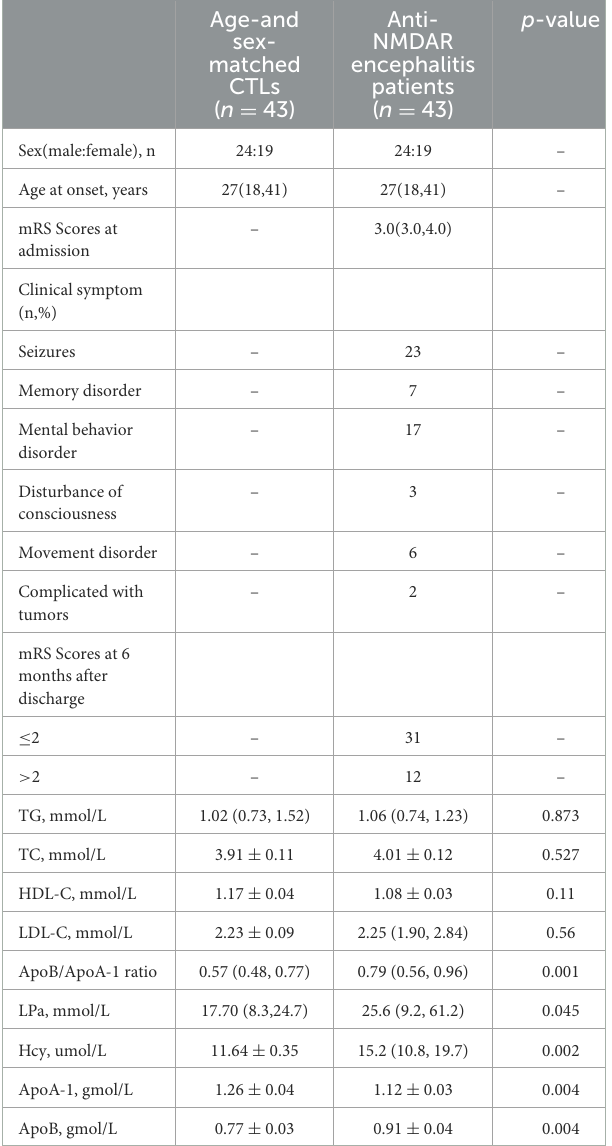
TABLE 1 Demographic features of patients with anti-NMDAR encephalitis and healthy controls.